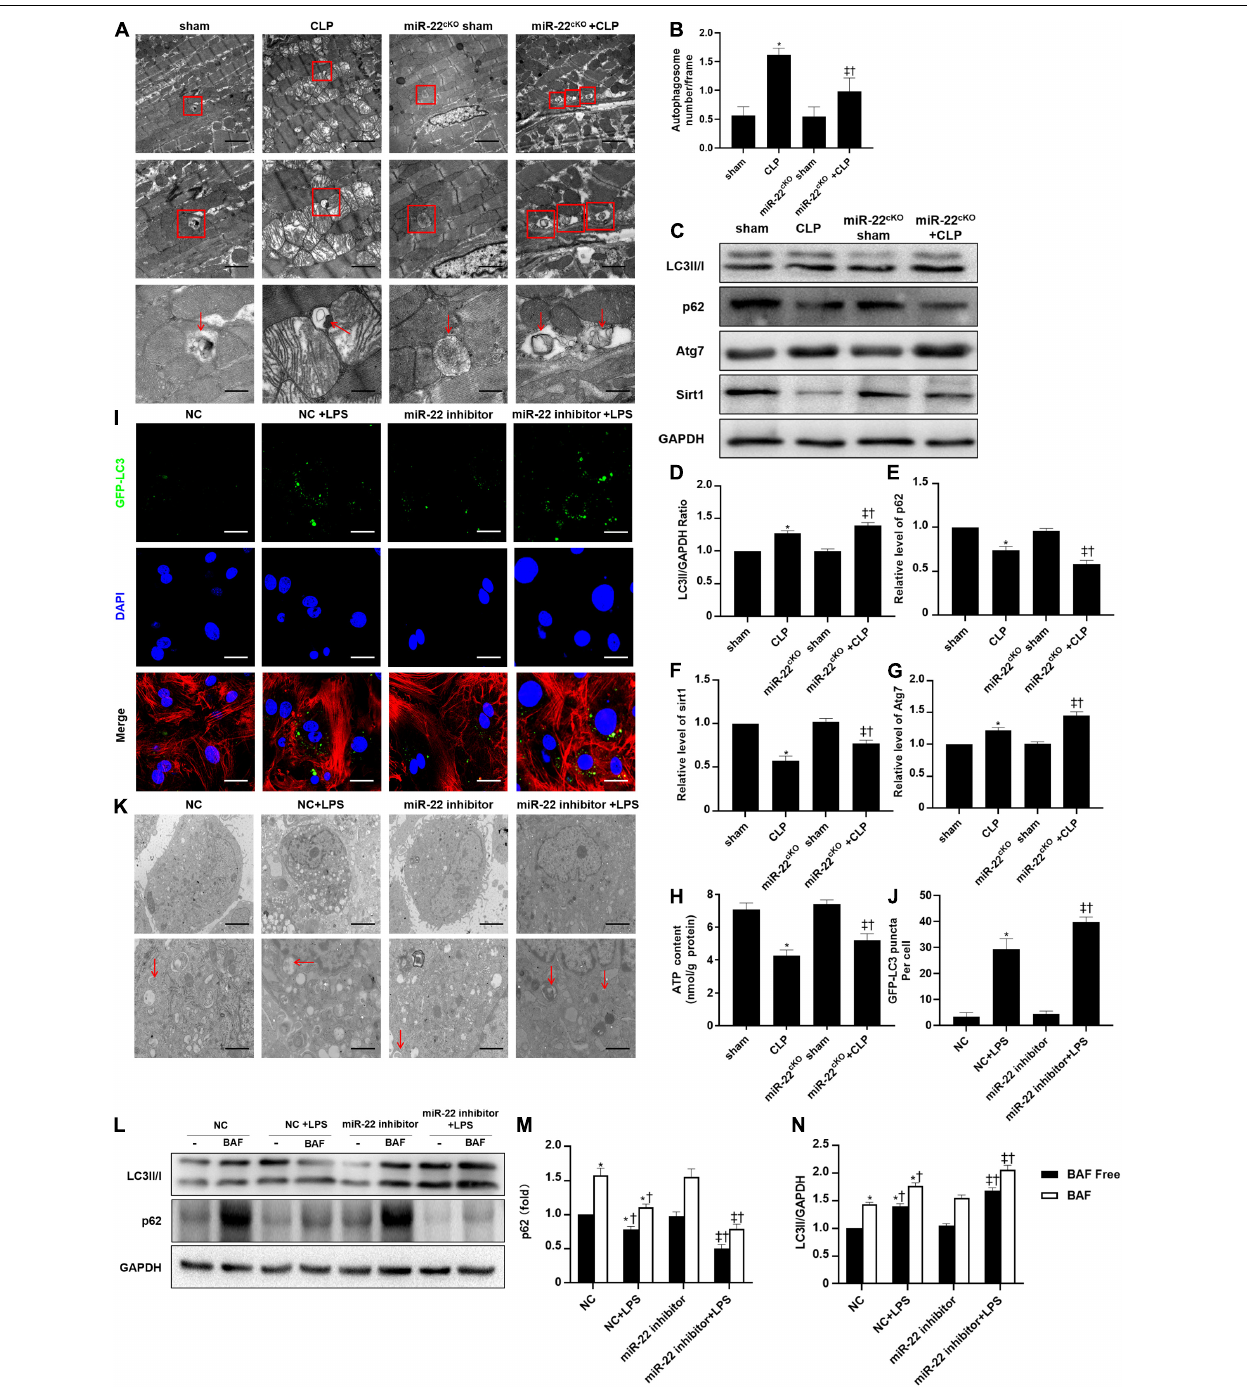
FIGURE 2 | Knocking out miR-22 increases autophagy levels in CLP-induced cardiomyopathic myocardium and enhanced autophagic flux in vitro in the presence of LPS. (A) Representative images of myocardial mitochondria ultrastructural morphology underwent different treatments. (B) Quantity of autophagosomes. (C) Representative images of blots. (D) LC3-II/GAPDH ratio. (E) Relative p62 protein level ratio; (F) Relative sirt1 protein level ratio; (G) Relative Atg7 protein level ratio; Data were expressed as mean ± SEM. * P < 0.05 vs. sham group; ‡ P < 0.05 vs. CLP group; † P < 0.05 vs. miR-22 cKO sham group. (H) ATP content. (I) Representative images of mitochondria in neonatal mice cardiomyocytes; Scale bar = 2 µ m, 1 µ m, 500 nm. (J,K) Representative images and quantitative analysis of GFP-LC3 puncta; Scale bar = 20 µ m. (L–N) Relative p62 protein level ratio with or without bafilomycin A1 treatment in condition of LPS; LC3-II/GAPDH ratio with or without bafilomycin A1 treatment in condition of LPS. * P < 0.05 vs. NC group; ‡ P < 0.05 vs. NC + LPS group; † P < 0.05 vs. miR-22 inhibitor group. All the experiments were repeated three times.